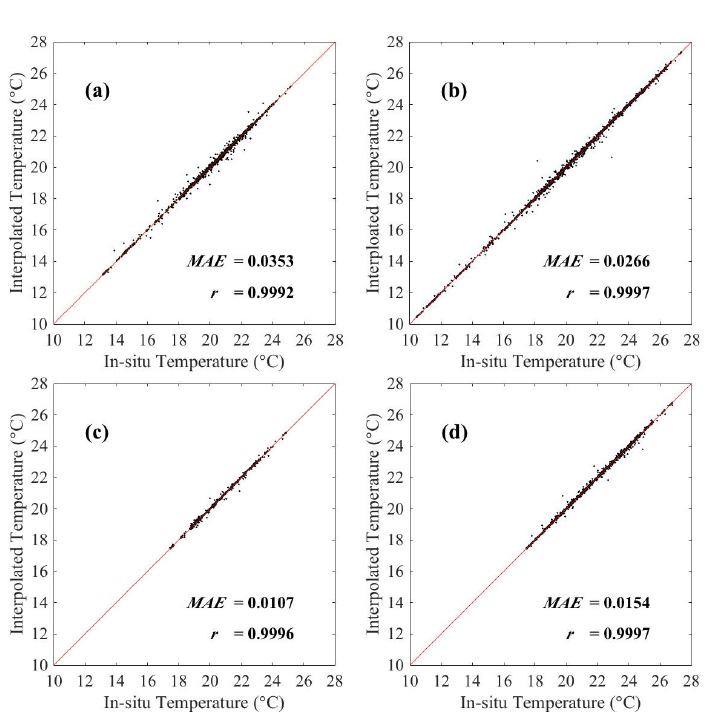
Figure 5. Scatterplots of the matchups between the interpolated and in situ temperature. The red line is the 1:1 line and 𝑟 is the correlation coefficient. ( a ) Summer 2010; ( b ) Summer 2011; ( c ) Autumn 2010; and ( d ) Autumn 2011.